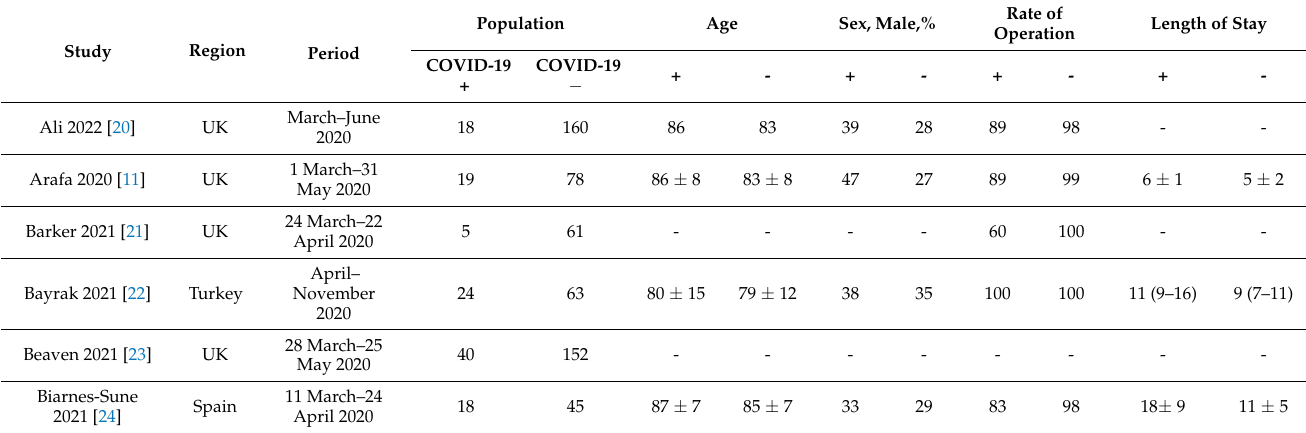
Figure 1. Flow diagram for the identification of relevant studies. Table 1. Baseline characteristics of the included